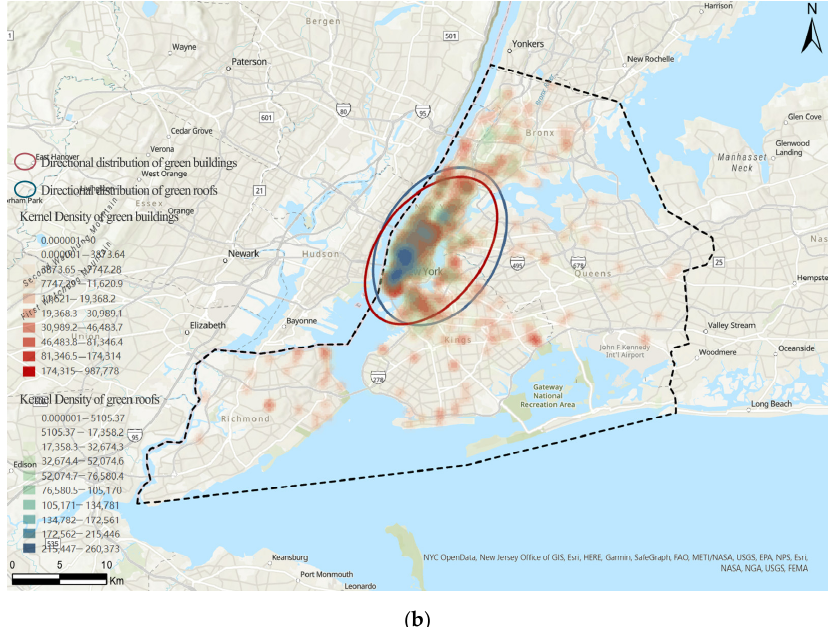
Figure 6. Comparison of spatial distribution between green roofs and green buildings. ( a ) San Francisco; ( b ) New York.